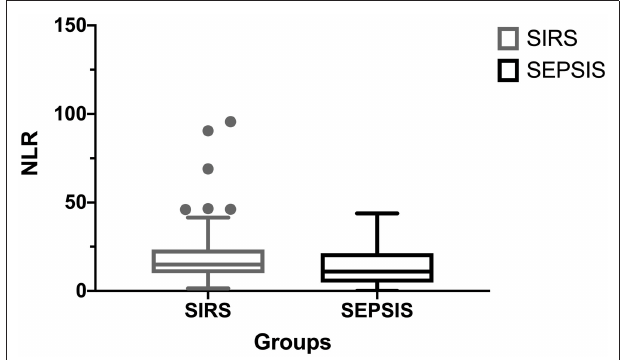
FIGURE 1 | Comparison of NLR between SIRS and septic dogs.